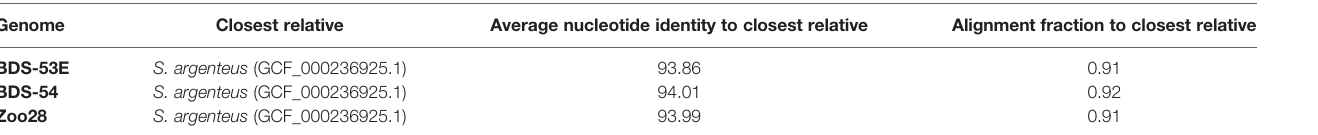
TABLE 3 | GTDB-tk results.